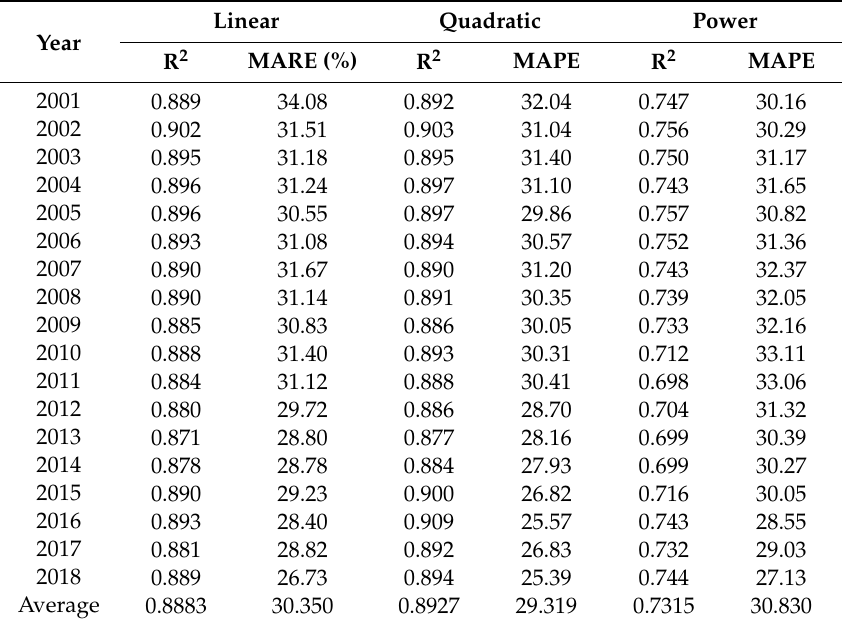
Table 6. Model fitting precision values between TNL and EPC in provincial